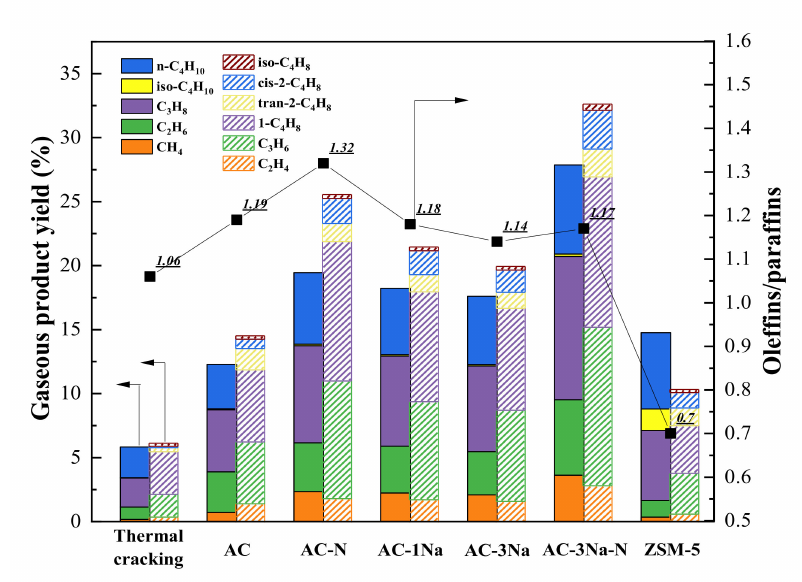
Figure 7. Gaseous product yield at 450 ◦ C and 4